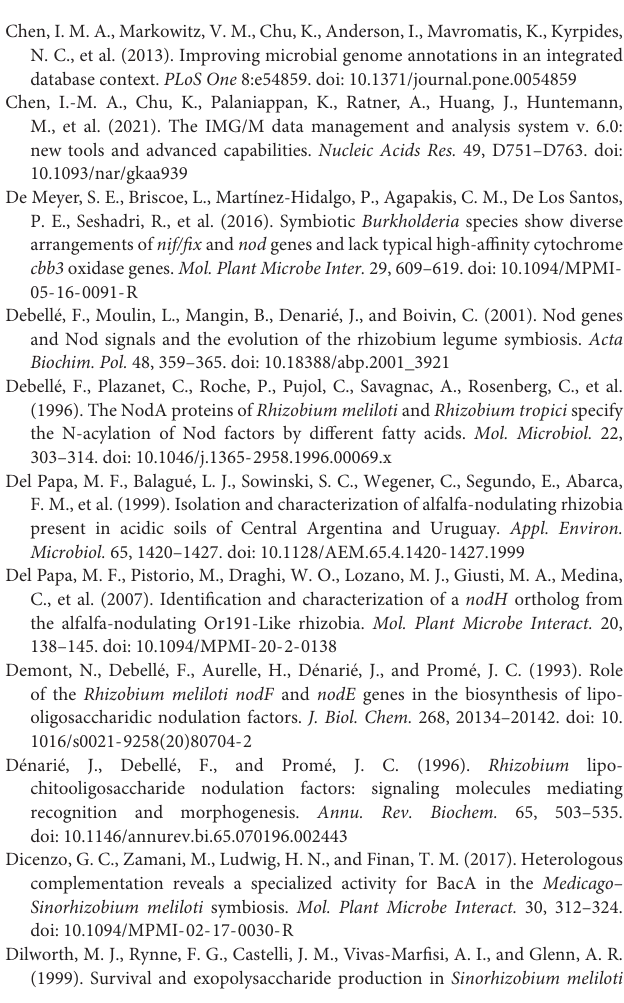
Supplementary Figure 3 | Resident prophages present in Rhizobium favelukesii OR191 imaged using PHASTER (Arndt et al., 2016). Scaffolds 4.5 and 84.85, as predicted by PHASTER, contain two putative prophages (A,C) , whereas scaffolds 7.8 and 91.92 contain two questionable prophages (B,D) , all of which are